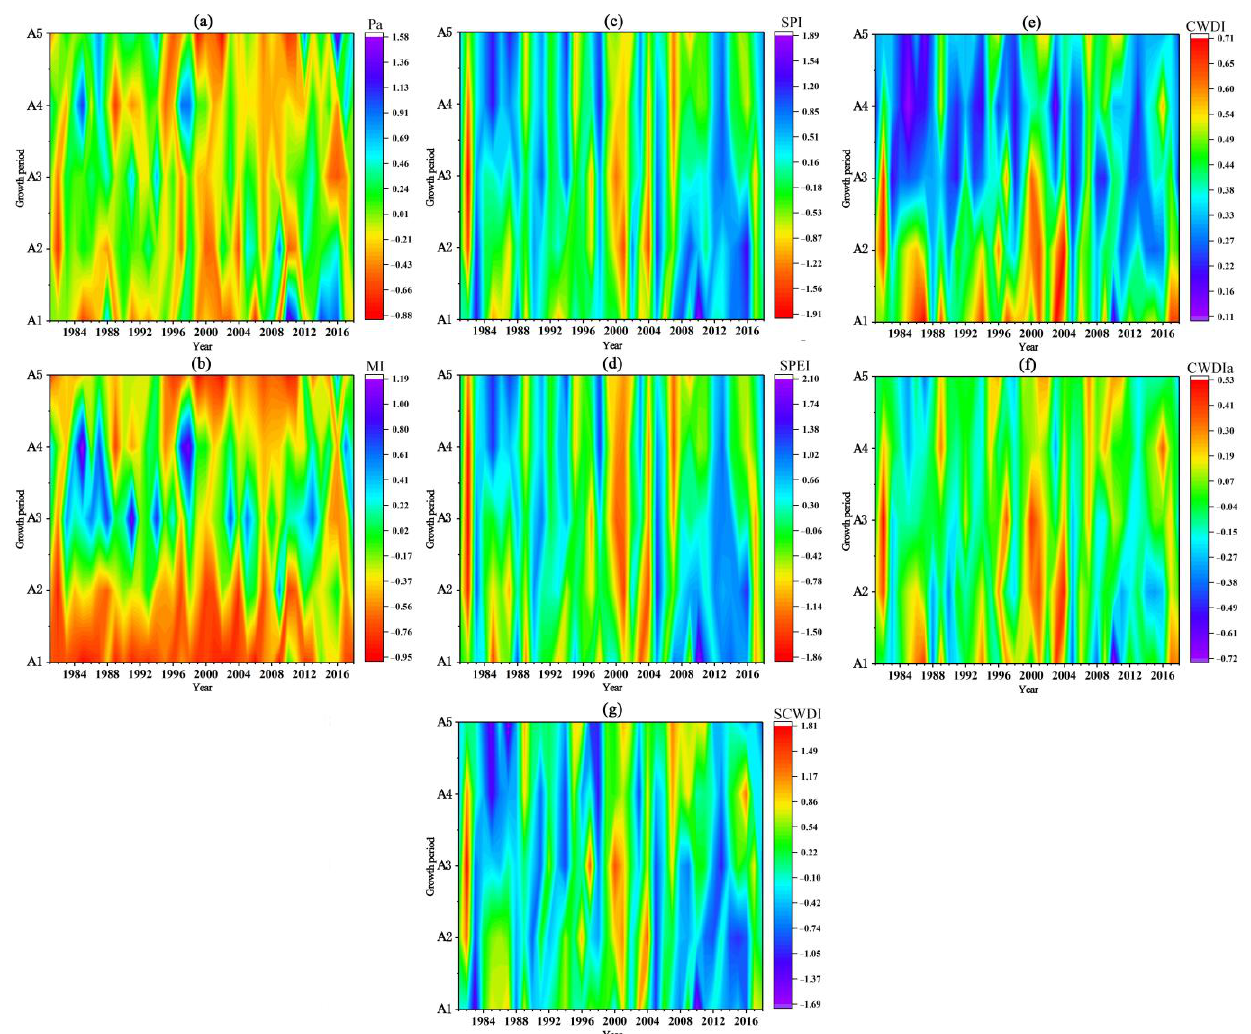
Figure 3. Comparison of different drought indexes in time series: ( a ) Pa; ( b ) MI; ( c ) SPI; ( d ) SPEI; ( e ) CWDI; ( f ) CWDIa; and ( g ) SCWDI.